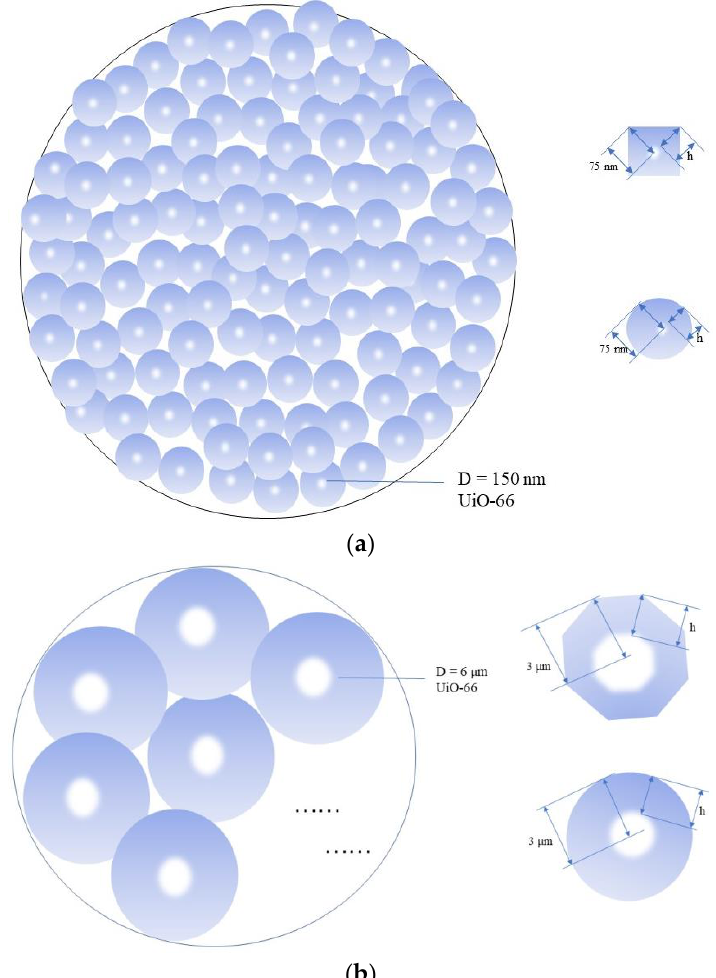
Figure 5. Cross-sectional view of the two crystal sizes of UiO-66 packing in the adsorption tubes (( a ) 6 μm , ( b ) 150 nm).